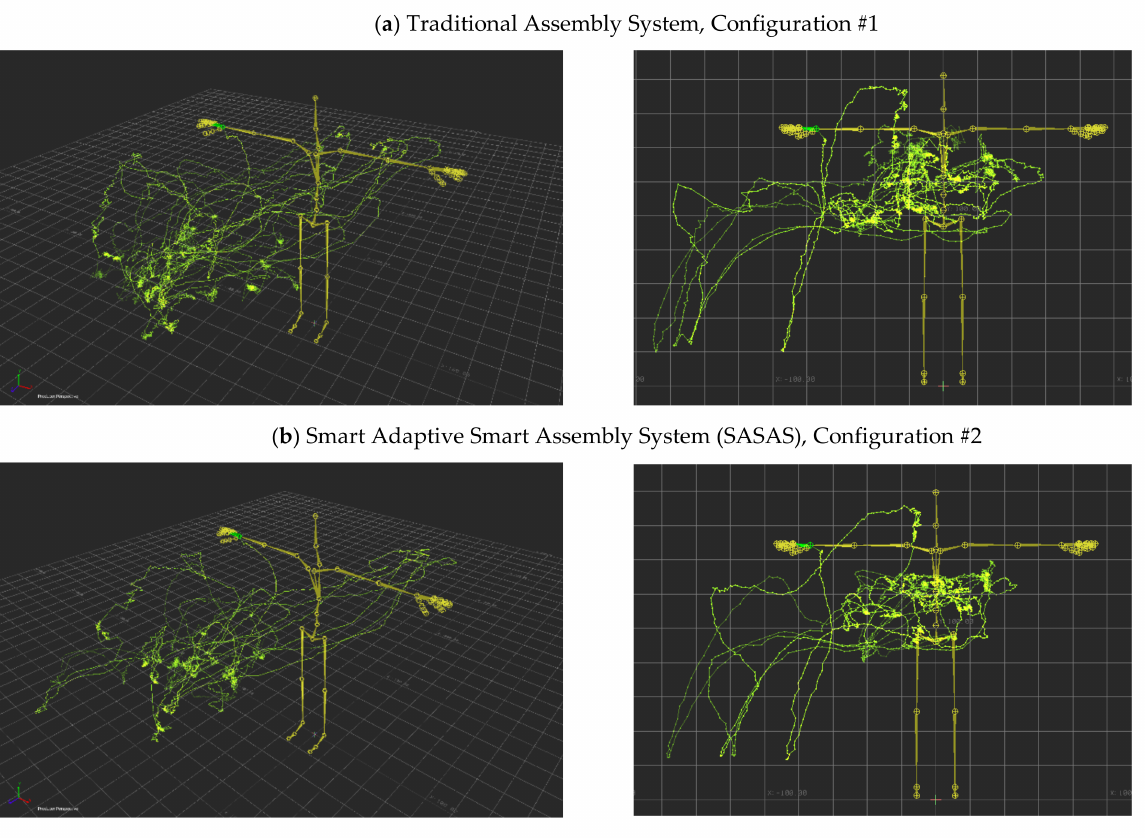
Figure 8. Spaghetti chart for ( a ) Configuration #1 and ( b ) Configuration